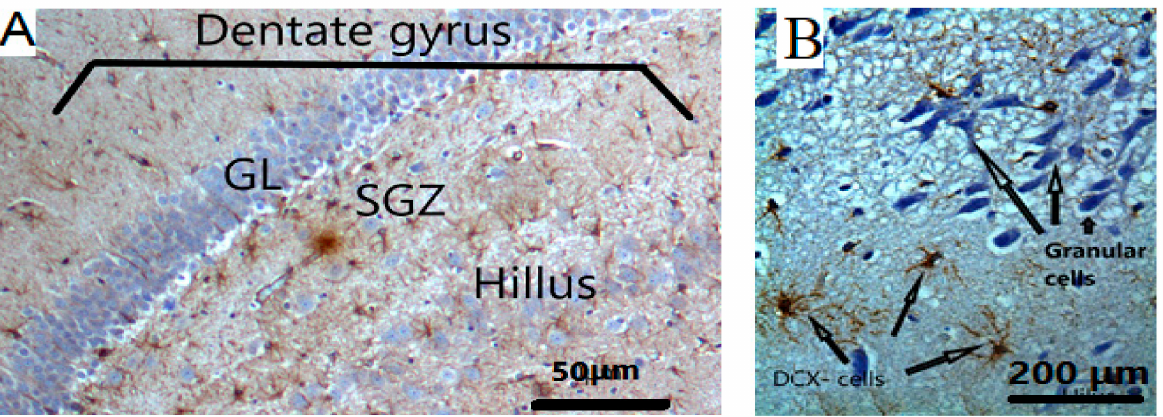
Figure 7. ( A ) The targeted area for the detection of DCX-positive staining immature neurons is the sub-granular (SGZ) layer in the dentate gyrus. Hilus; polymorphic layer of dentate gyrus; GL: Granular layer, magnifications are at 100 × . ( B ) DCX-positive staining immature neurons are identified by